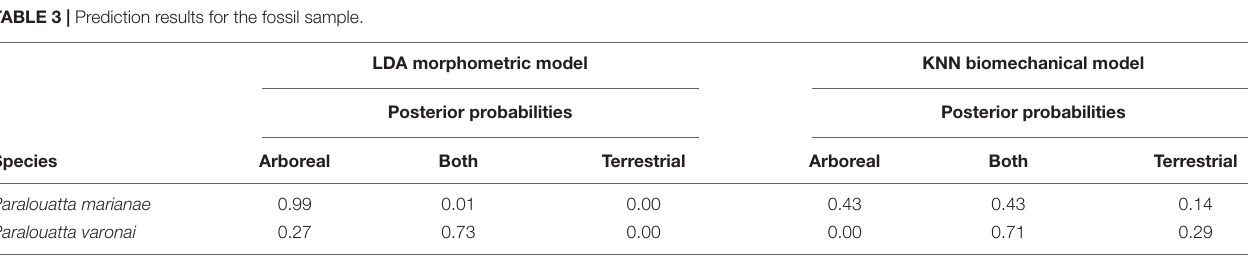
FIGURE 7 | Decision boundary plots for (A) morphometric and (C) biomechanical data. The two variables that contributed the most to each one of the models are displayed. The space is colored depending on what substrate preference the (A) LDA or the (B) KNN algorithm predict that region belongs to, whereas the lines between colored areas represent the decision boundaries. Color intensity indicates the certainty of the prediction in a particular graph area (i.e., darker colors mean a higher probability of belonging to a certain category). Symbols surrounded by a white rim correspond to misclassified specimens. In addition, variable importance scores for the predictors used are provided for the (B) morphometric (only the top 20 variables are shown) and (D) biomechanical models. TABLE 3 | Prediction results for the fossil